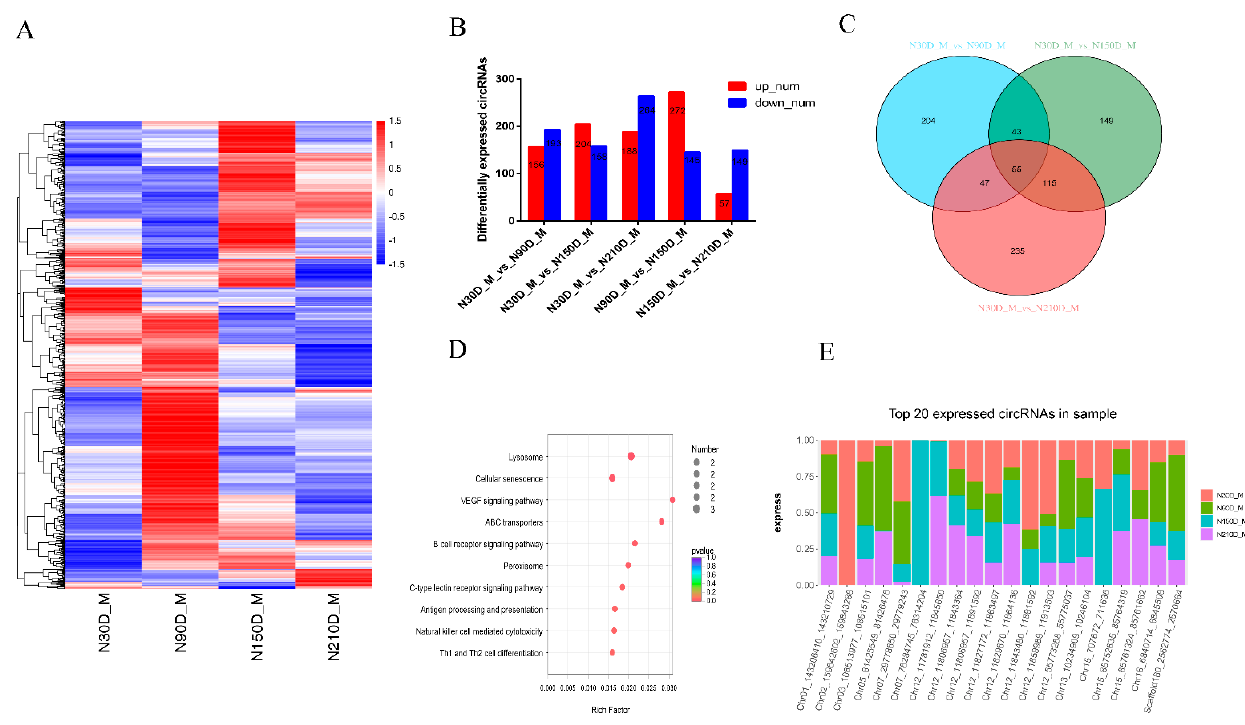
Figure 2. Differentially expressed (DE) circRNAs and their expression modes in skeletal muscle. ( A ) Heat map of all DE circRNAs among the five compared groups (30 d vs. 90 d, 30 d vs. 150 d, 30 d vs. 210 d, 90 d vs. 150 d, and 150 d vs. 210 d groups). ( B ) Number of differentially expressed circRNAs in skeletal muscle vs. means versus. ( C ) The number of common DE circRNAs in skeletal muscle. ( D ) KEGG pathway analysis of common DE genes in skeletal muscle. The top 10 enriched KEGG pathways ranked by p -values are shown. ( E ) Top circRNAs expressed in skeletal muscle.